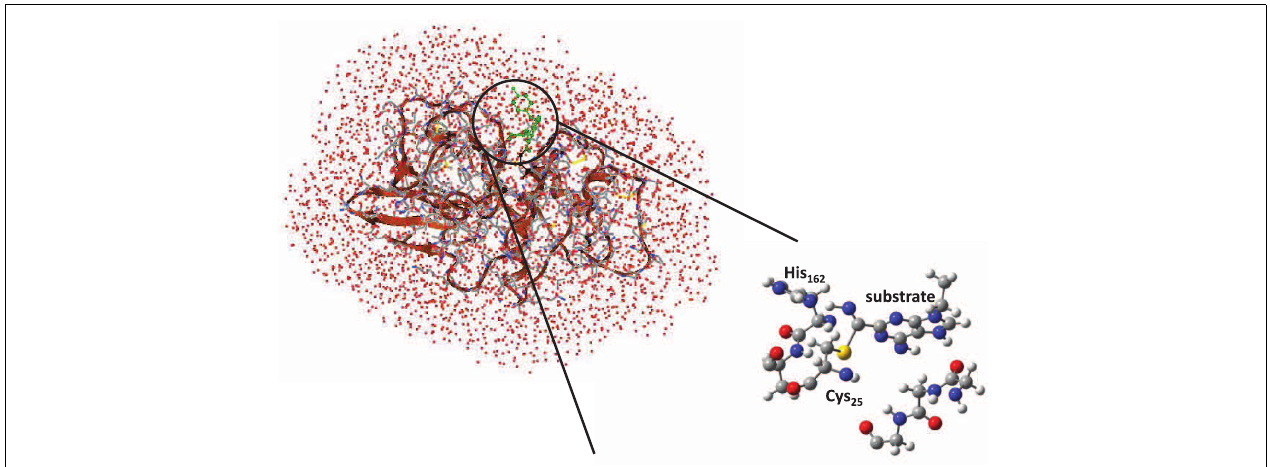
FIGURE 3 | QM/MM model and QM/MM active site as based on the 1U9V cathepsin K structure.